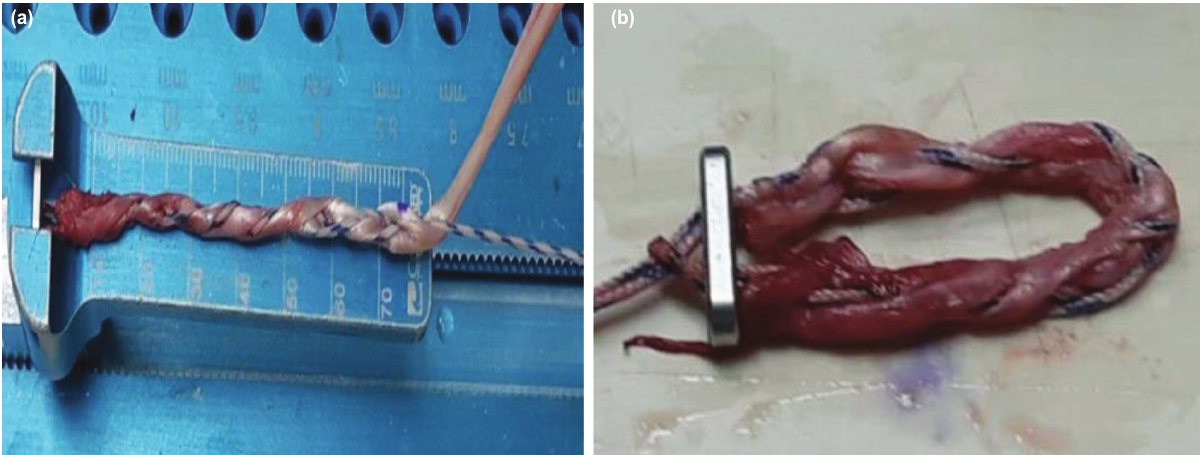
(a) Gracilis autograft was prepared using No. 5 Hi-Fi high strength (ConMed Linvatec, Largo, FL). The graft was prepared using Fig. 2: whip stitch technique. (b) The prepared graft was later secured with GraftMaxTM button (Conmed Inc, Utica,